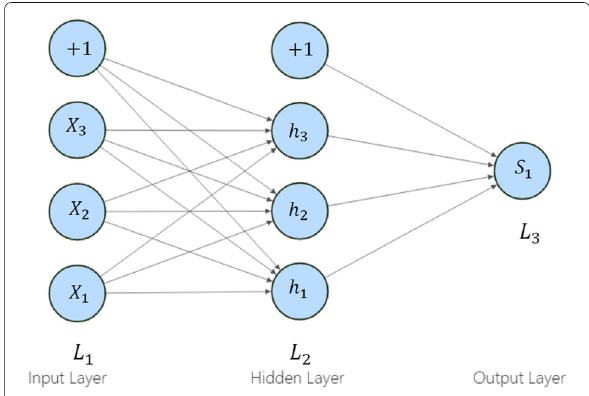
Fig. 3 A simple feed-forward Neural Network